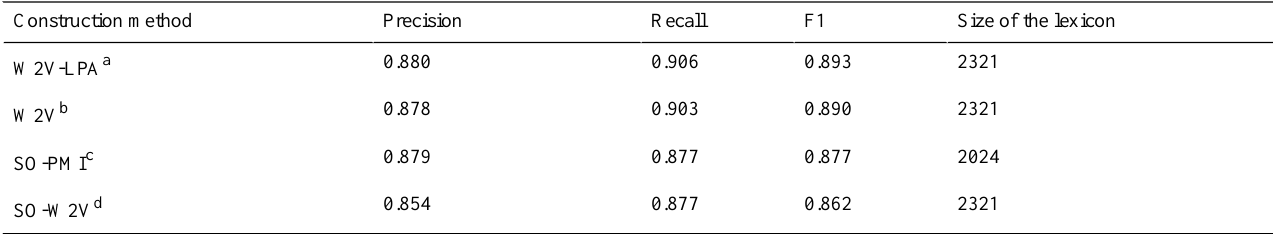
Table 4. Performance of lexicon construction